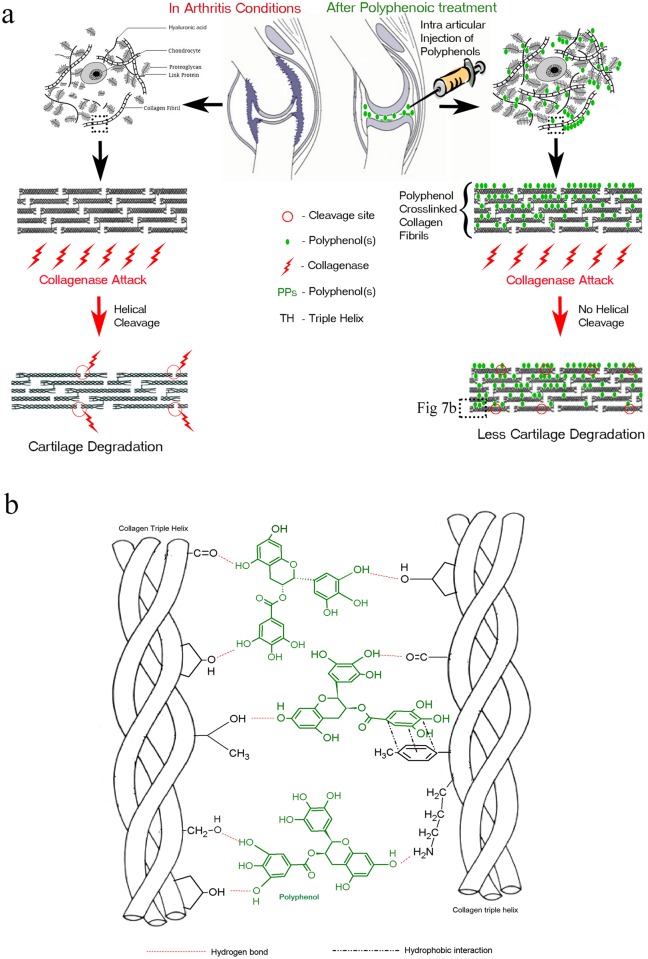

Polyphenolic treatment to articular cartilage protects collagen against degradation a) Mechanistic pathway of polyphenols role in protecting articular cartilage b) Possible Hydrogen and hydrophobic interaction of polyphenols with type II collagen triple helical molecules in the cartilage matrix.